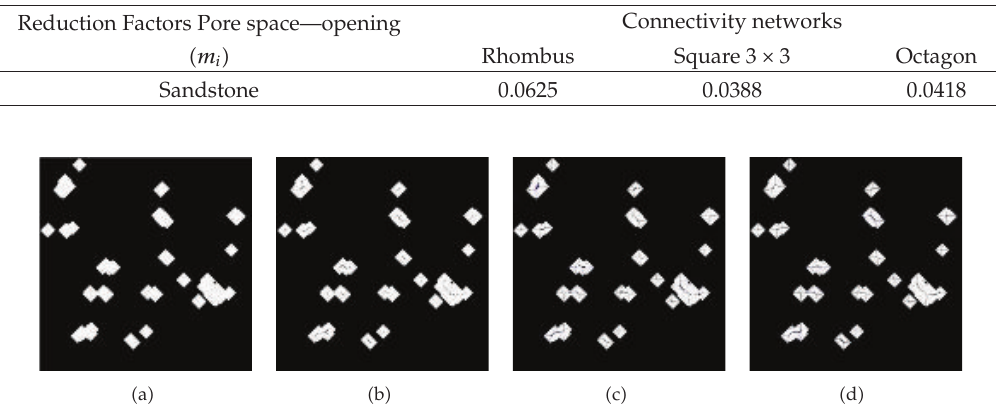
Table 2: The reduction factor by opening process in Figure 5 (cid:2) k (cid:3) .